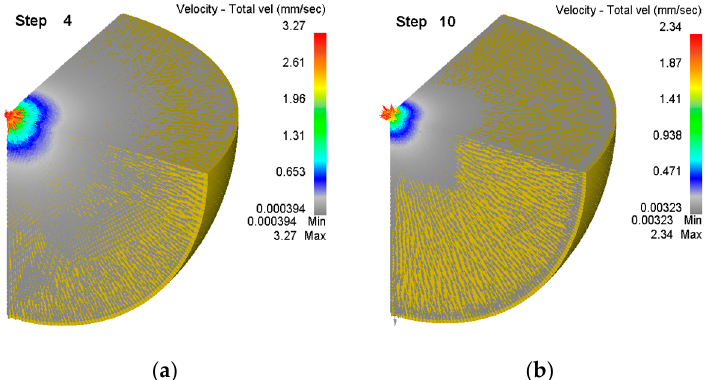
Figure 7. Cloud diagram of void velocity in steel ball. ( a ) The beginning of compacting the void; ( b ) At the step 10, the void is shrinking.